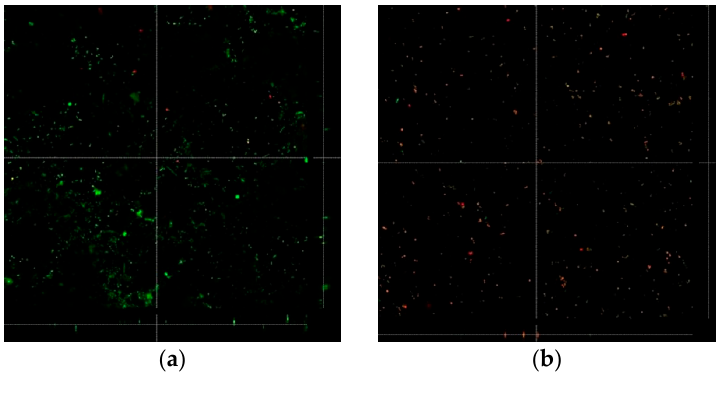
Figure 8. Cell viability images of Streptococcus mutans. Green fluorescence indicates viable cells; red fluorescence indicates dead cells. The number of live cells in the P0 group was reduced compared to the control group. ( a ) Control (no treatment), ( b ) P0 group (immediately after treatment), ( c ) P1 group (24 h after treatment), ( d ) P2 group (48 h after treatment), ( e ) P3 group (72 h after treatment).